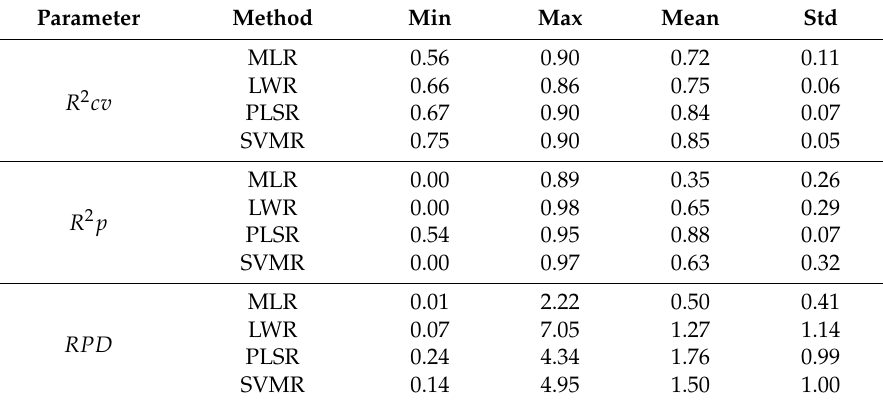
Table 1. Parameters for model performance